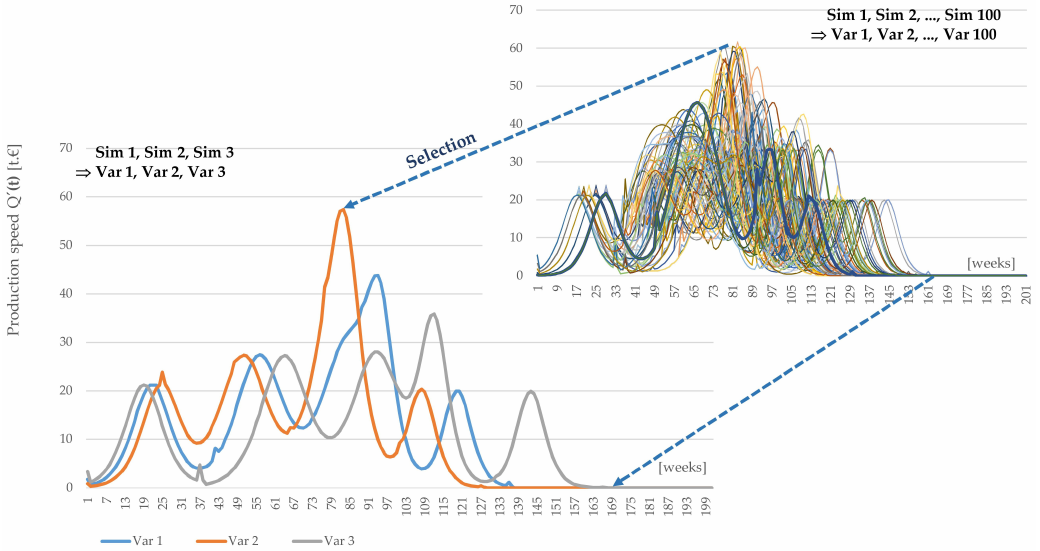
Figure 4. Var 1, 2, 3–assessment of project production speeds and durations–logistic distribution of resources. (Source: